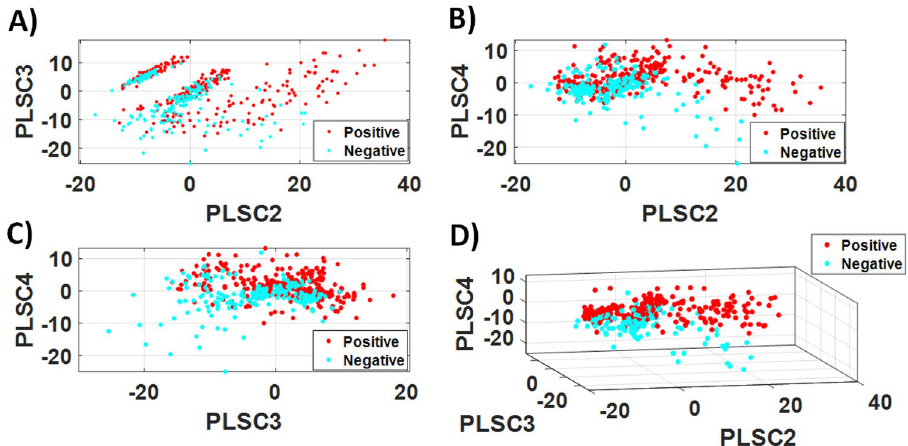
Figure 7. PLS score plots of ( A ) PLSC2 × PLSC3, ( B ) PLSC2 × PLSC4, ( C ) PLSC3 × PLSC4, ( D ) PLSC2 × PLSC3 × PLSC4 for COVID-19 positive and negative groups of the LIQUID 2 dataset.